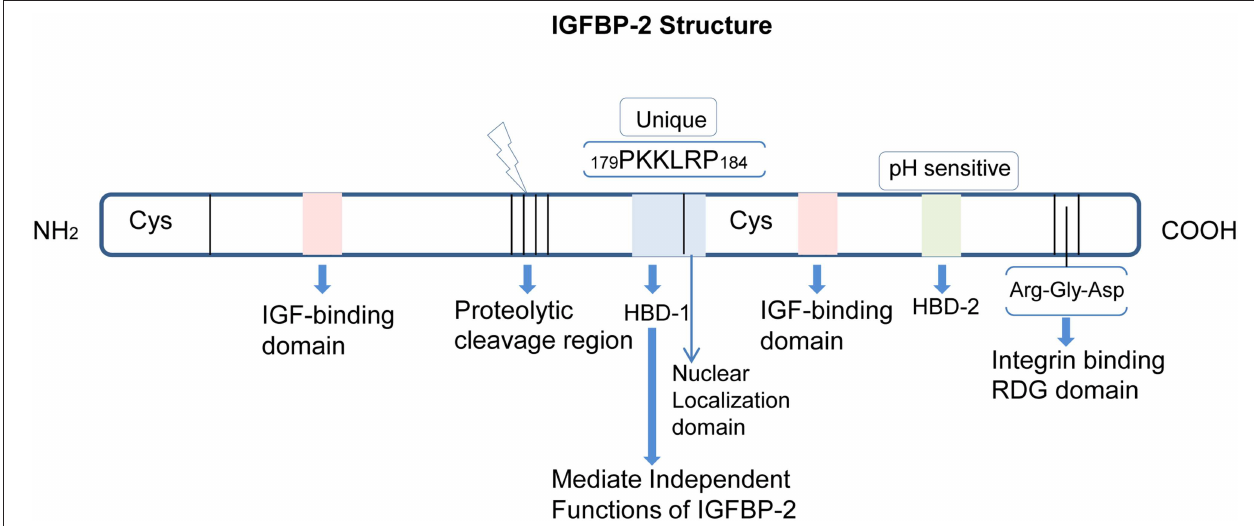
FIGURE 1 | Structure and domains of IGFBP-2. IGFBP-2 consists of N-terminal and C-terminal regions linked by a linker domain. Both the N- and C-terminal have one IGF-binding domain. There is a proteolytic cleavage site between the two terminals. The HBD-1, HBD-2, and RDG domains are located in the cysteine-rich C-terminal region. The nuclear localization domain is adjacent to the HBD1